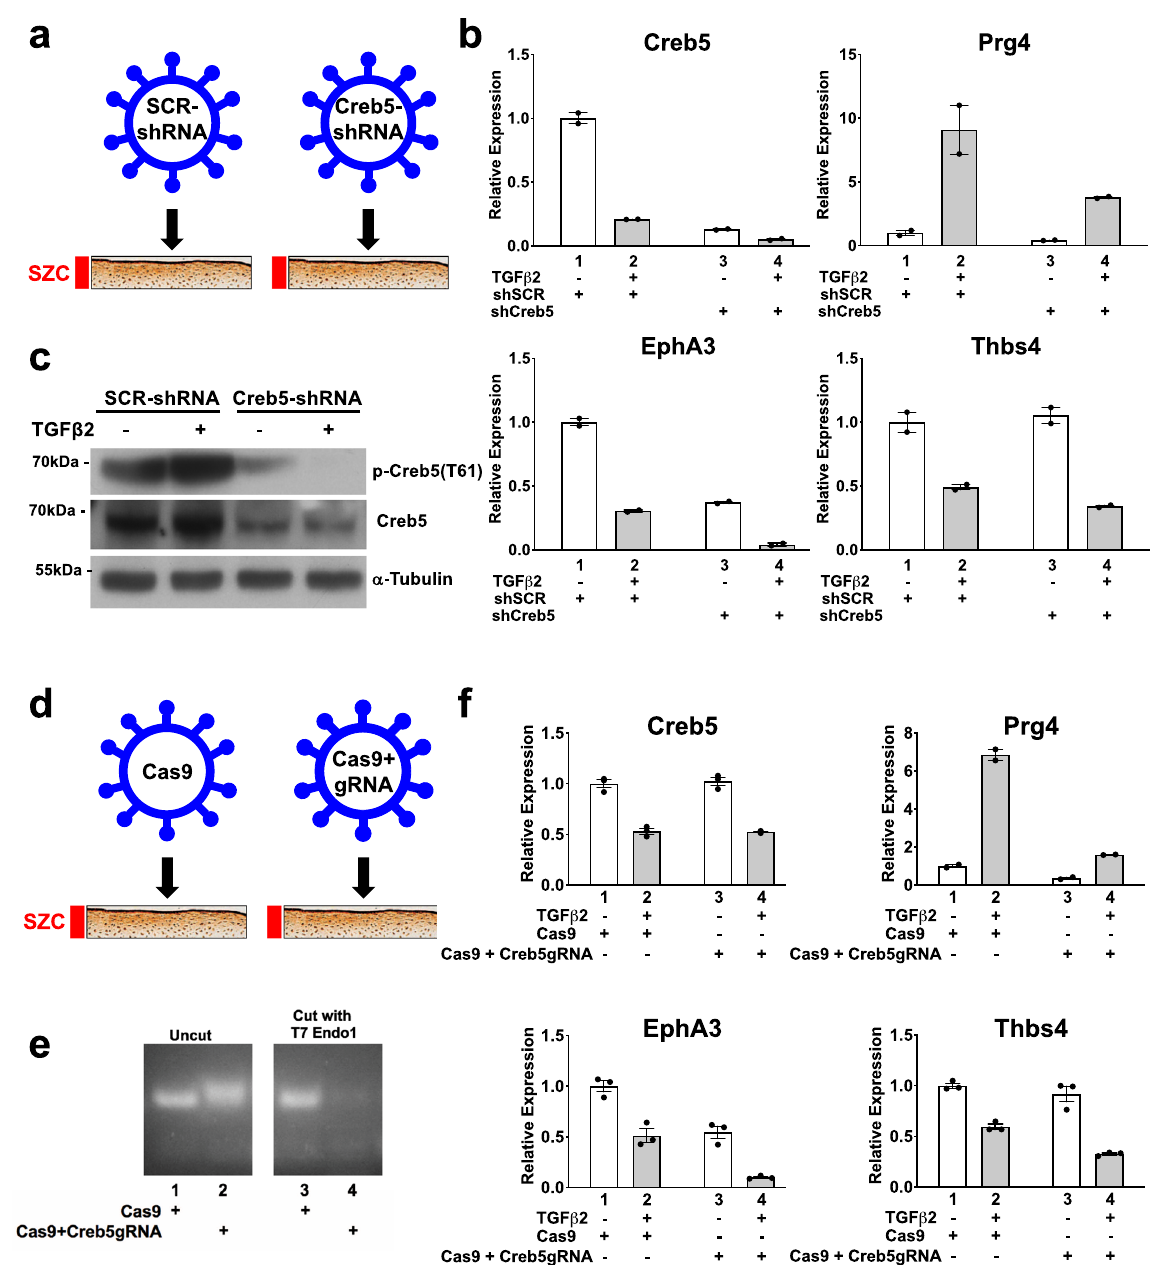
Fig. 3 Creb5 function is necessary for TGF- β -dependent induction of Prg4 in super fi cial zone articular chondrocytes. a – c shRNA-mediated knock-down of Creb5 in super fi cial zone articular chondrocytes. SZCs were infected with a lentivirus encoding either control scrambled shRNA (shSCR, lanes 1 and 2) or shCreb5 (lanes 3 and 4), after selection in puromycin, the cells were cultured in either the absence (white) or presence (gray) of TGF- β 2 (20 ng/ml) for 3 days. b Gene expression was assayed by RT-qPCR and normalized to Gapdh . Error bar indicates standard error of the mean ( n = 2 technical repeats). Similar results have been obtained in three independent biological repeats. c Western analysis of proteins in SZCs recognized by antibodies directed against either phospho-Creb5 (T61), total Creb5, or α -tubulin. Similar results have been obtained in two independent biological repeats. d – f CRISPR-Cas9 mediated mutation of the DNA-binding domain of Creb5 in SZCs. SZCs were infected with a lentivirus encoding Cas9 alone or Cas9 plus a Creb5 guide RNA (targeting the DNA-binding domain), as indicated. After selection in puromycin, the cells were cultured in either the absence (white) or presence (gray) of TGF- β 2 (20 ng/ml) for 3 days. e T7 Endonuclease 1 assay (which cleaves at mismatches) is displayed for the RT-PCR amplicon encoding the bZIP domain of Creb5 . f Gene expression was assayed by RT-qPCR and normalized to Gapdh . Error bar indicates standard error of the mean ( n = 3 technical repeats). Similar results have been obtained in two independent biological Identi fi cation of Prg4 regulatory elements . Because the above chromatin (reviewed in 50 ). To identify genomic sites with differ- fi ndings collectively implicate Creb5 as a key regulator of Prg4 ential chromatin access in SZCs and DZCs, we performed the expression, we sought to understand the basis for its crucial role in assay for transposase-accessible chromatin (ATAC-seq, 51 ) on driving SZC-speci fi c gene expression. Active enhancers and pro- nuclei isolated separately from these populations of primary moters are both marked by relatively accessible regions of bovine articular chondrocytes. The 907 sites selectively accessible